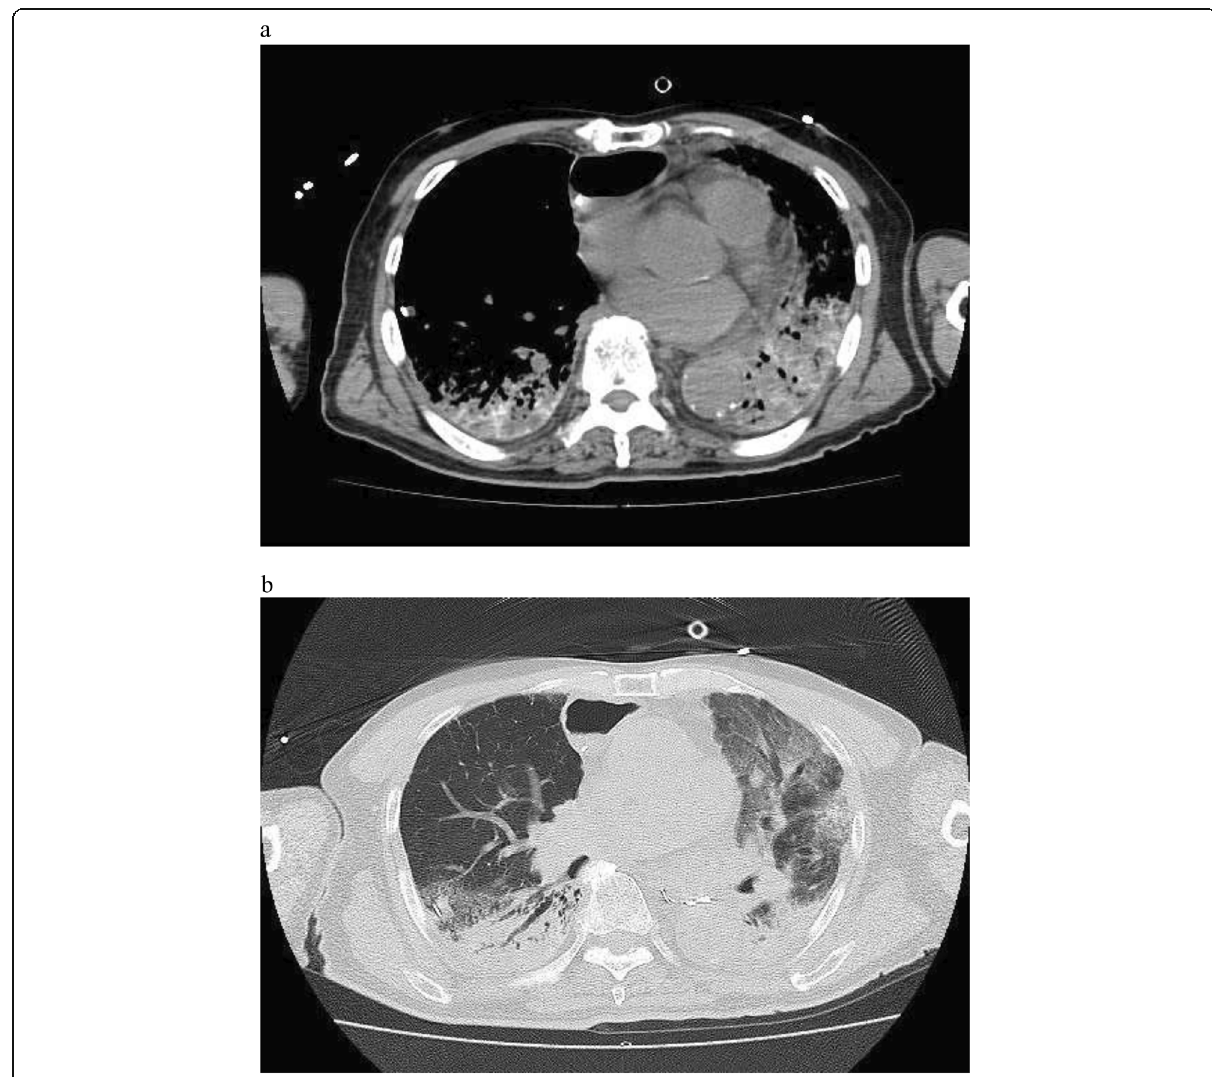
Fig. 2 Computed tomography image showing high-density substance in the lung ( a ) and ground-glass opacity in bilateral lungs ( b